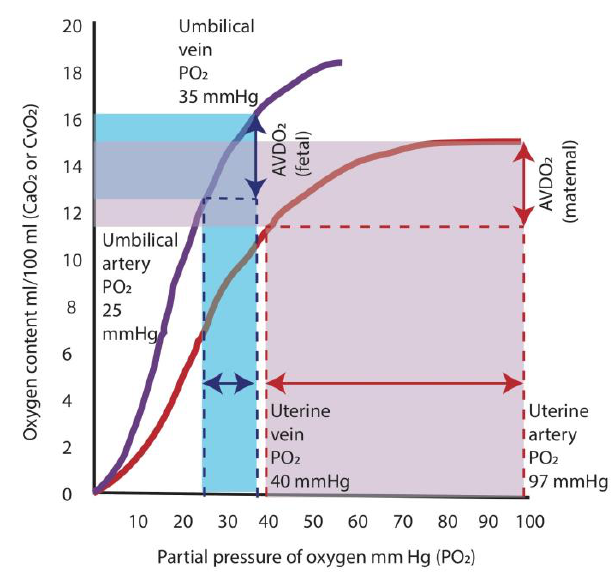
Figure 4. Oxygen hemoglobin dissociation curves and oxygen supply. The higher oxygen affinity of fetal hemoglobin (purple curve) shifts the oxygen dissociation curve to the left, which results in a greater release in oxygen at lower arterial partial oxygen tension (PO 2 ) compared to adult hemoglobin (red curve). In the adult, a decrease in PO 2 from 97 mm Hg (level present in arterial blood) to 40 mm Hg (level in venous blood) results in a release of oxygen amounting to ≈5 ml/dL (area shaded in red). For the fetus, the difference between the umbilical venous PO 2 (35 mm Hg) and the umbilical arterial PO 2 (25 mm Hg) results in a similar release of oxygen to the tissues of ≈4 ml/dL (area shaded in blue). AVDO 2 : arterio-venous difference in oxygen content. Data from [20] (Copyright Satyan Lakshminrusimha).